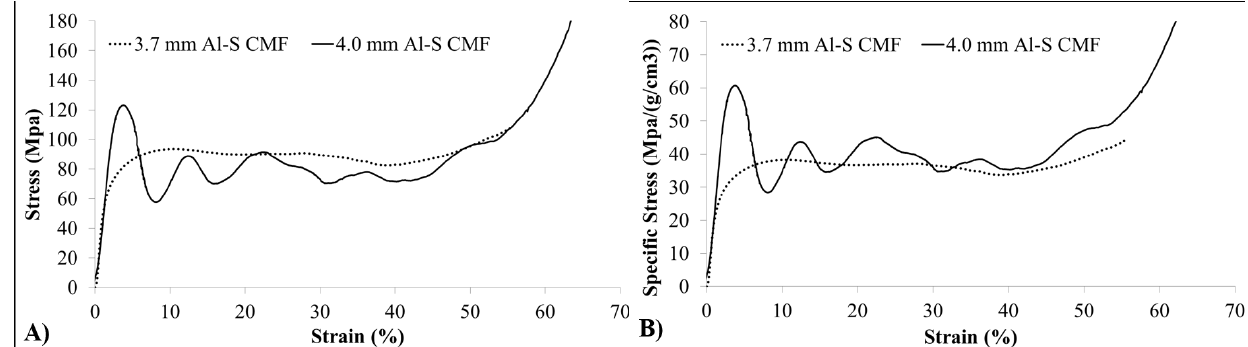
Figure 10. ( A ) Engineering stress vs. strain and ( B ) Specific engineering stress (stress/density) vs. strain plots for quasi-static compression tests on Al-S CMF manufactured using 3.7 mm and 4.0 mm